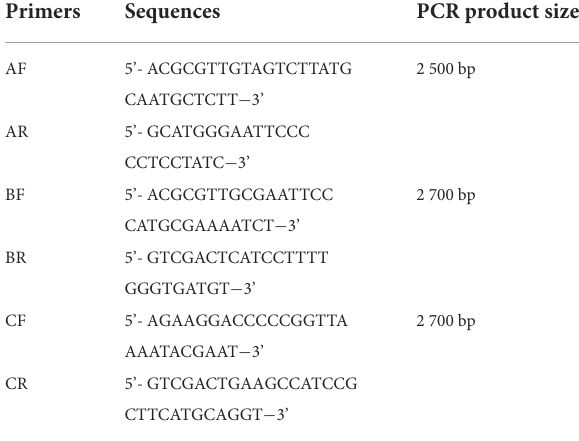
TABLE 1 Sequences of the primers for chicken common neoplastic diseases.